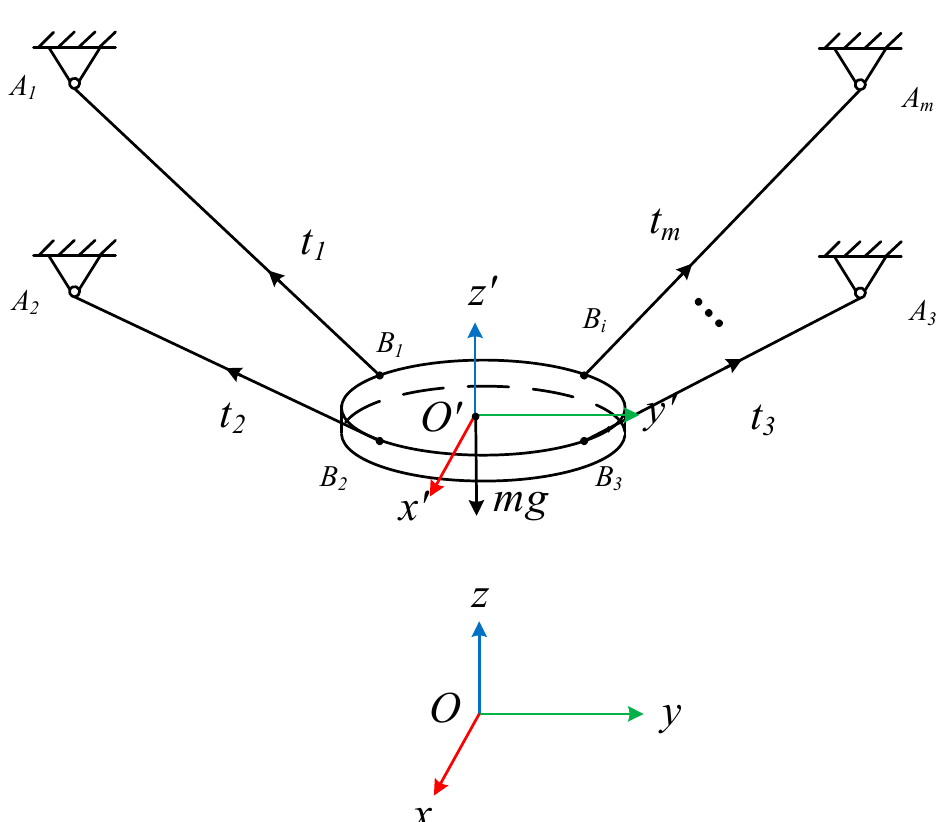
Figure 1. The schematic structure of a cable-driven parallel robot (If m < n , it is an under-constrained CDPR.).